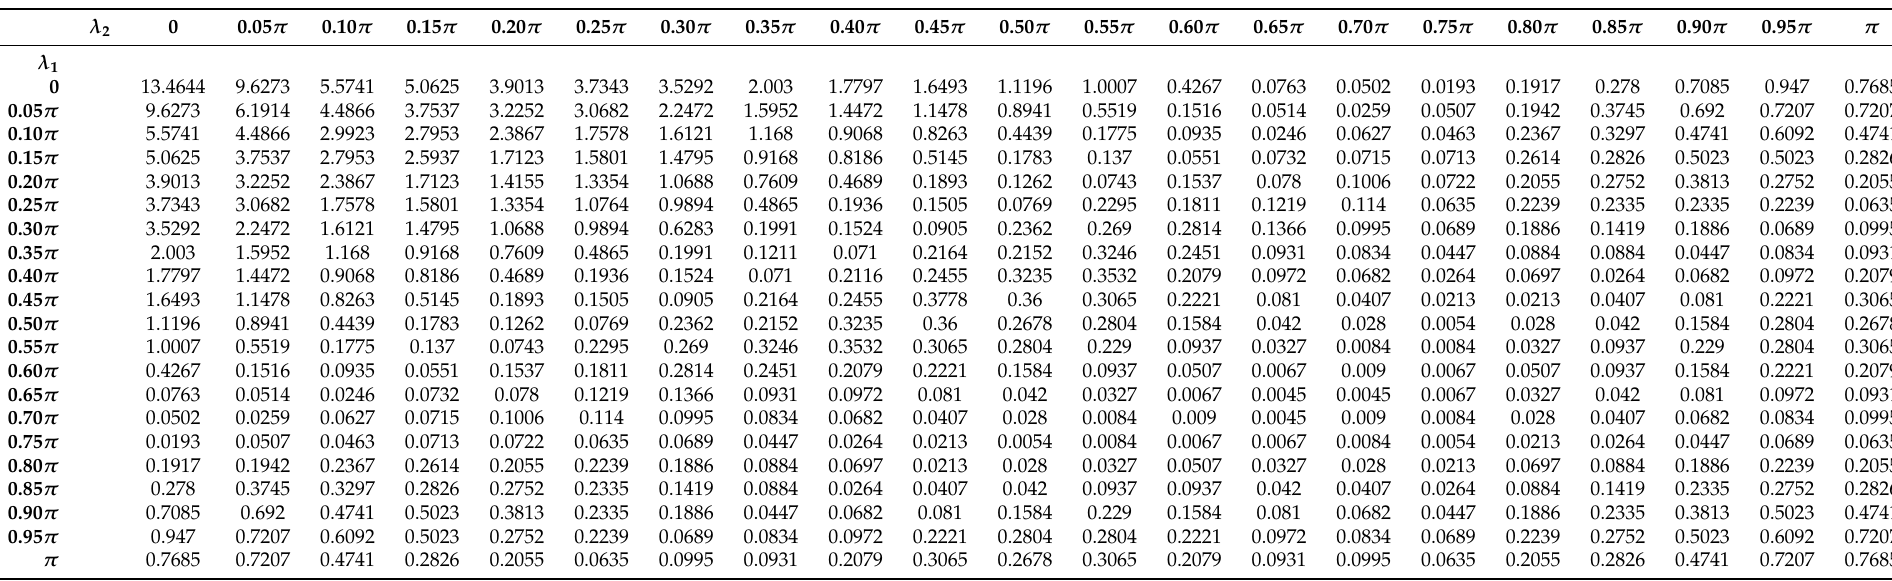
Table 6. Numerical values of smoothed multitapered biperiodogram of DCGINAR(1) model with M = 16 and β =